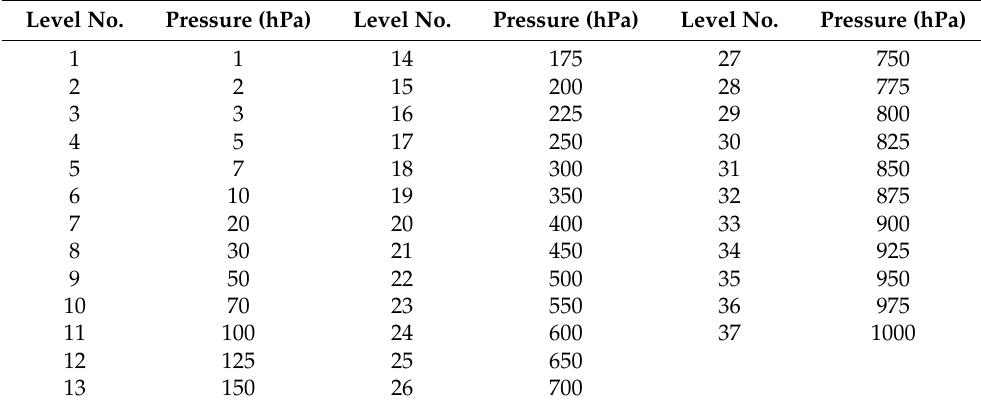
Table 2. Vertical pressure levels of the ERA5 reanalysis hourly data. Level No. Level